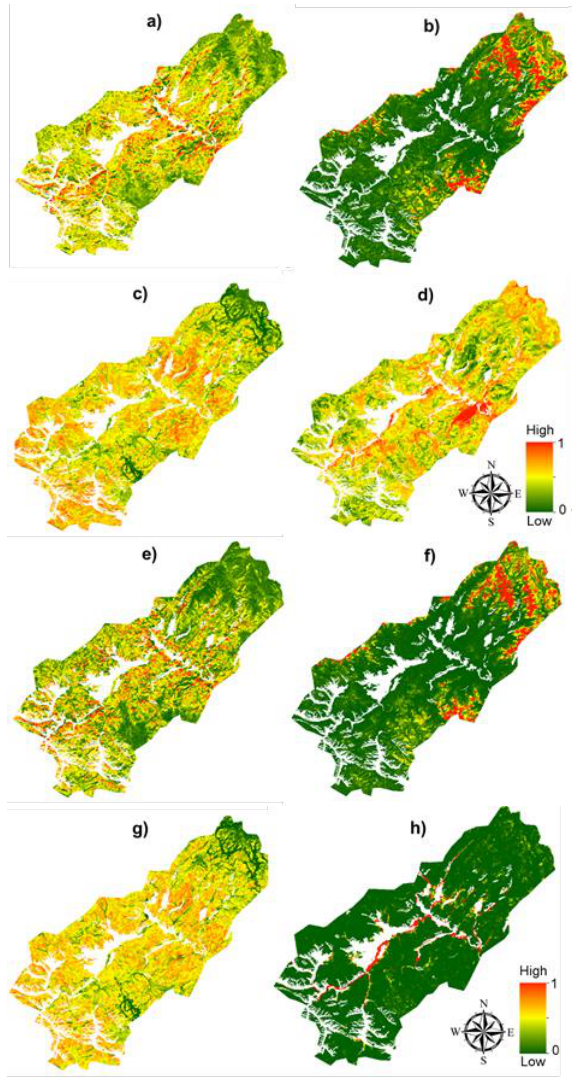
Figure 5. Probability for the presence of tree species using satellite imagery a) birch, b) cedar, c) larch, d) willow and using Landsat satellite imagery coupled with topographic variables e) birch f) cedar, g) larch and h) willow. Red and green indicate high (1) and low (0) probability respectively.